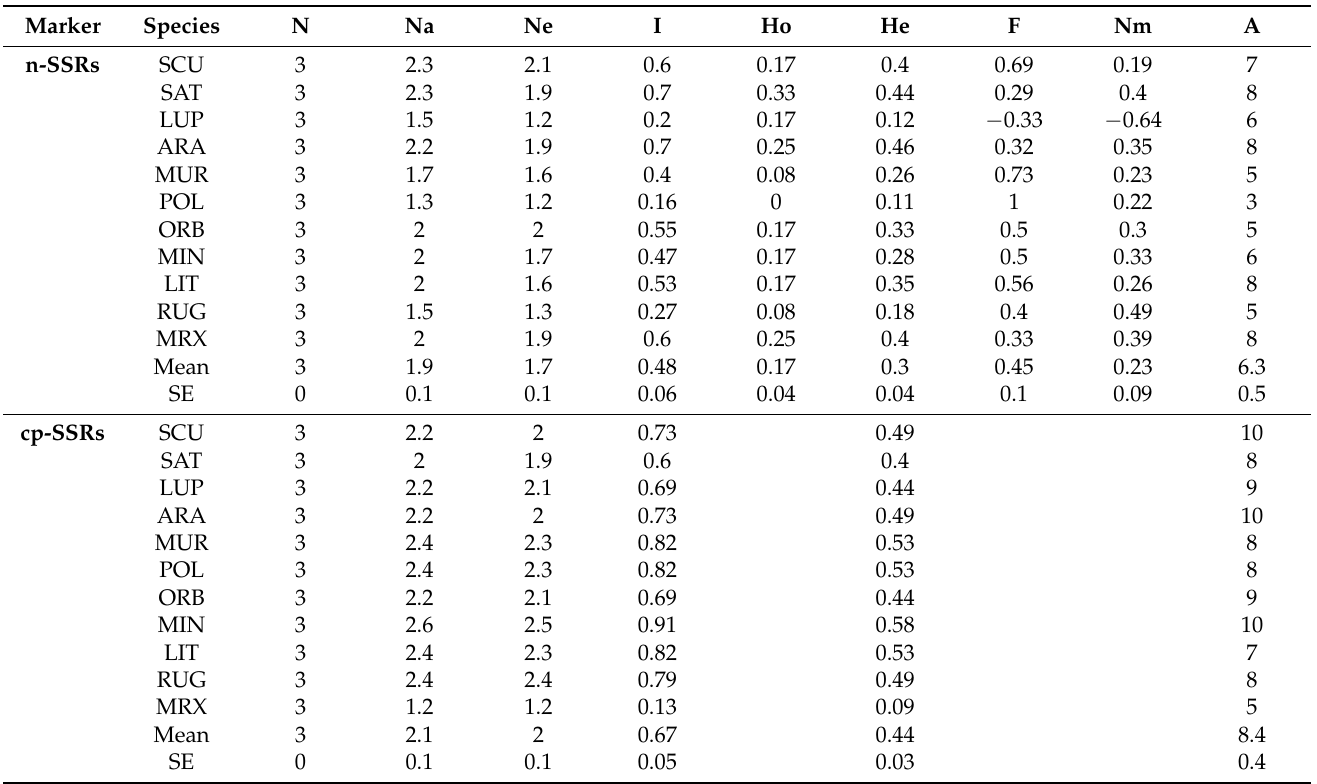
Table 3. Genetic diversity among the 11 Medicago species investigated in this study.